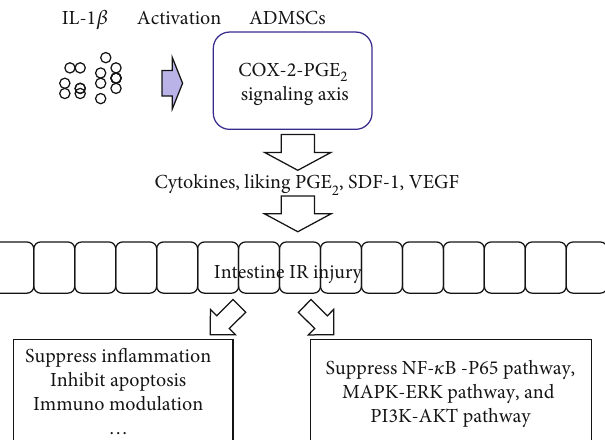
Figure 8: Activated ADMSC enhanced healing of intestinal IR injury through activation of COX-2-PGE activated ADMSC-suppressed apoptosis and in fl ammation and inhibited activation of NF- κ B-P65, MAPK-ERK, and PI3K-AKT pathways that were induced by IR